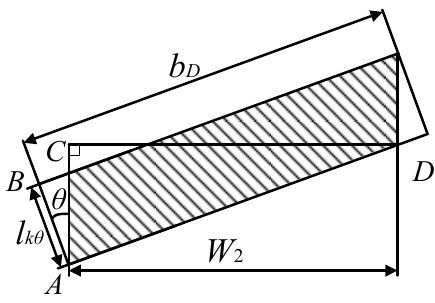
Figure 9. Area of contact area with included angle.